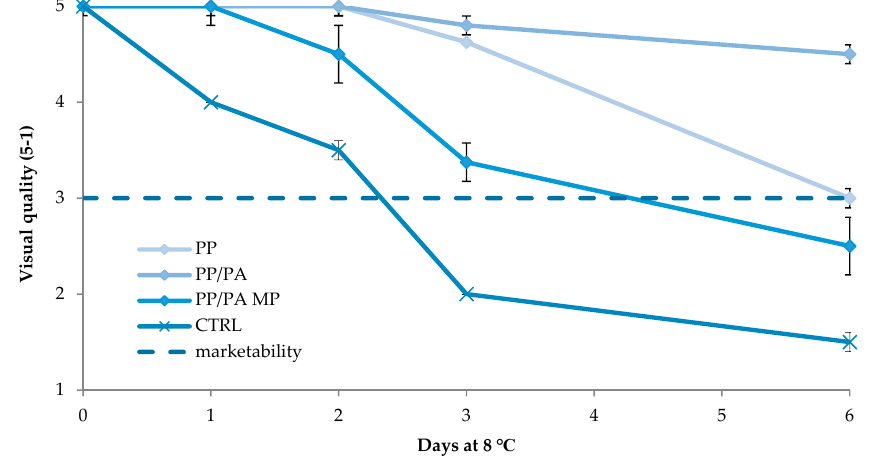
Figure 3. Changes in visual quality of fresh-cut iceberg lettuce stored in MAP using PP, PP/PA or PP/PA MP bags or in air (CTRL). Data are mean ( n = 3) ± standard deviation.